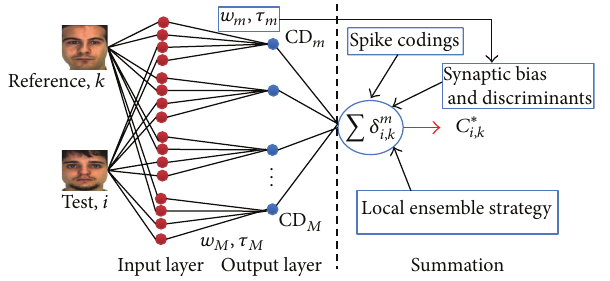
Figure 8: Coincidence detection classifier evaluating synchroniza- tion of two classes of inputs, namely, reference face 𝑘 and test face 𝑖 comprising 𝑀 CD neurons as output